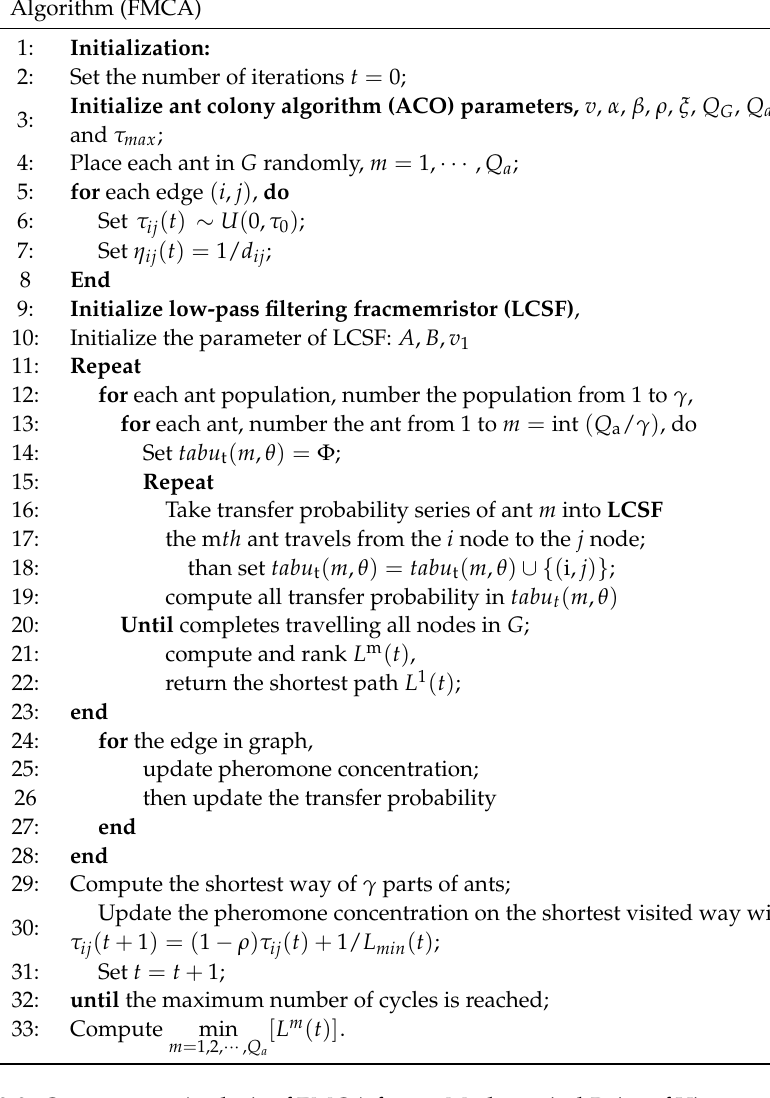
Algorithm 1: Proposed Iterative Algorithm of Fractional-Order Memristive Ant Colony Algorithm